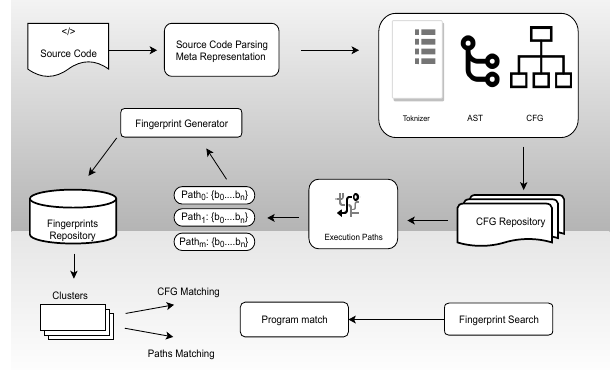
Figure 1. Similarity Detection Overview: High level steps of the proposed